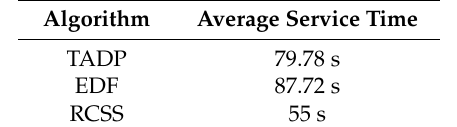
Table 4. The value of average service time.